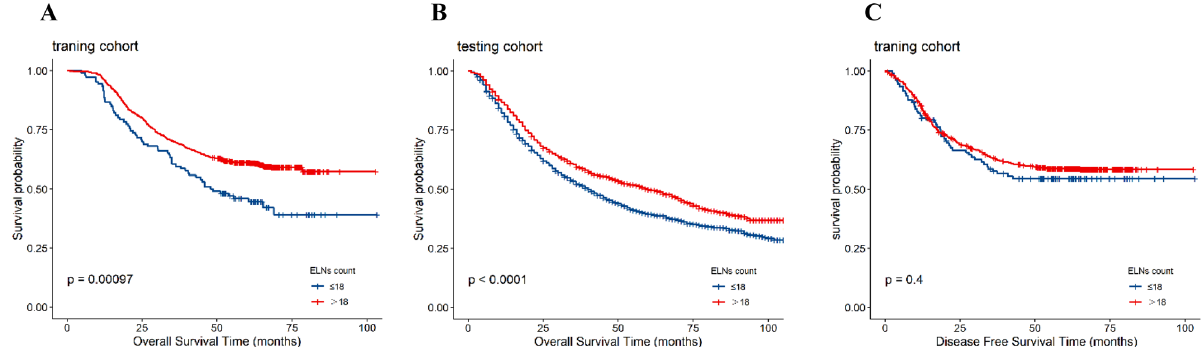
Figure 1. Overall Survival and Disease Free Survival of EC patients at the optimal ELNs